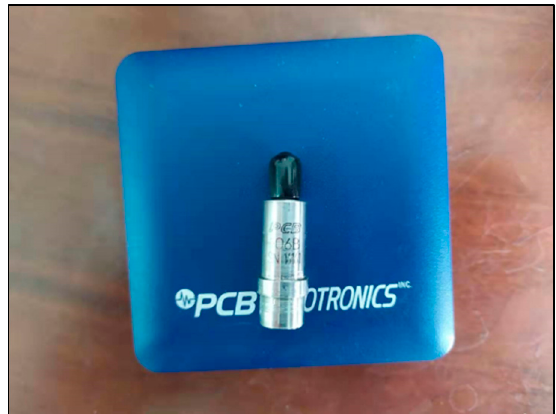
Figure 5. PCB 106b acoustic sensor.